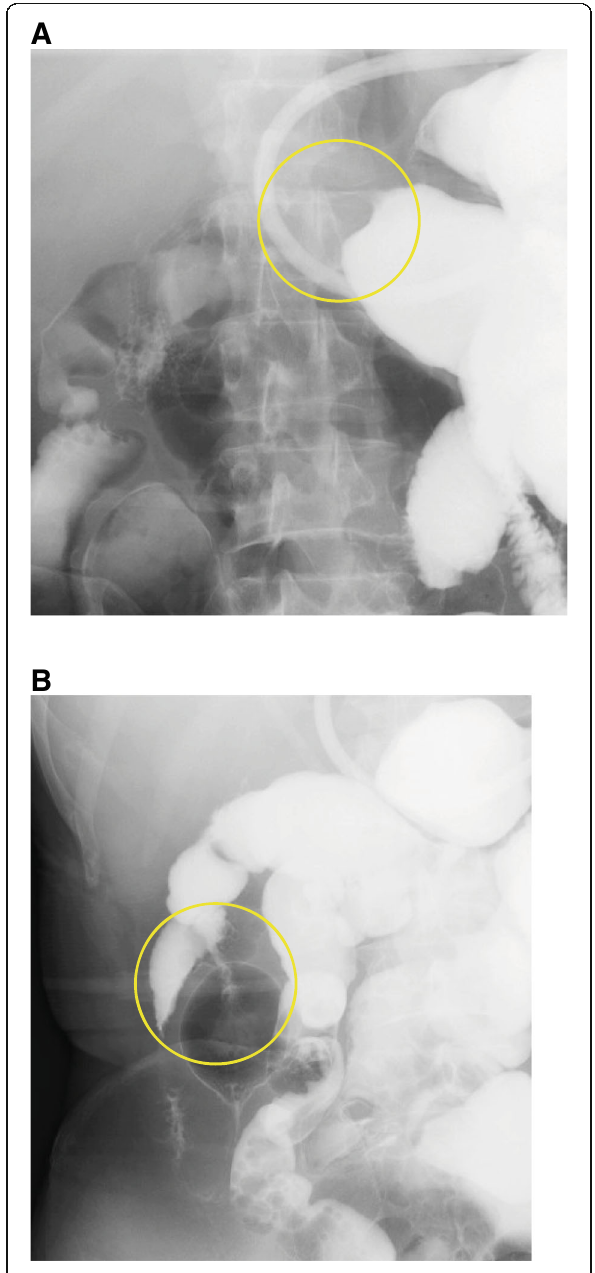
Fig. 1 We introduced 200mL gastrografin into the gastrointestinal tract via a gastric tube. This examination revealed two stenosing sections of the small bowel, as seen on radiological enteroclysis (yellow circles in the image a and b )